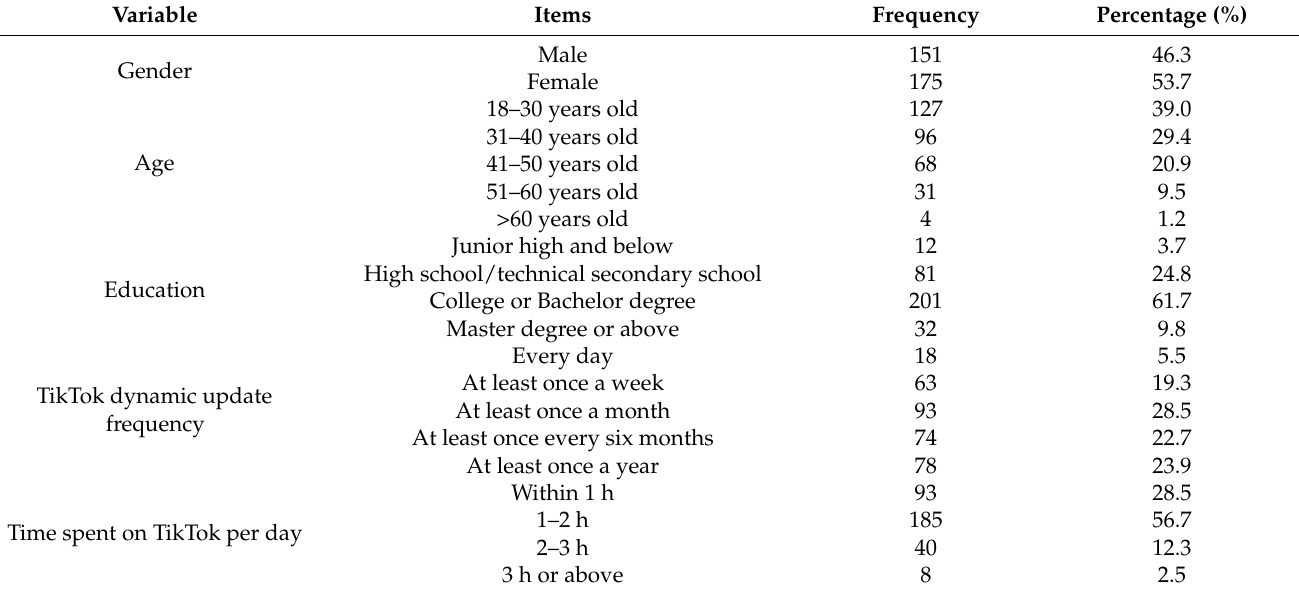
Table 1. Basic statistics of samples ( n =